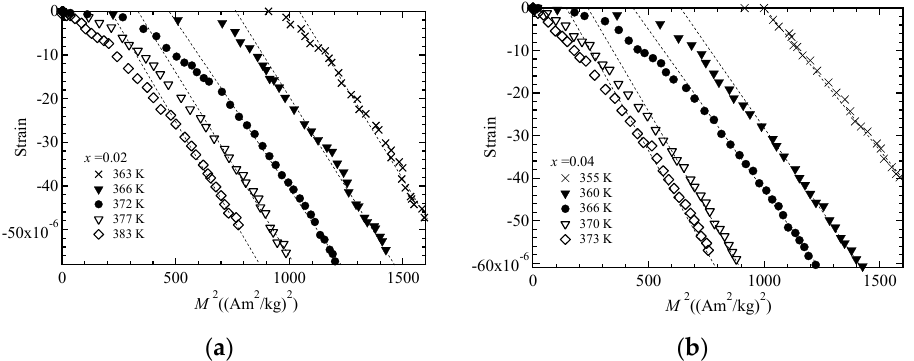
Figure 6. The M 2 dependence of magnetostriction for ( a ) x = 0.02 and ( b ) x = 0.04. The dotted straight lines are included as a visual guide.